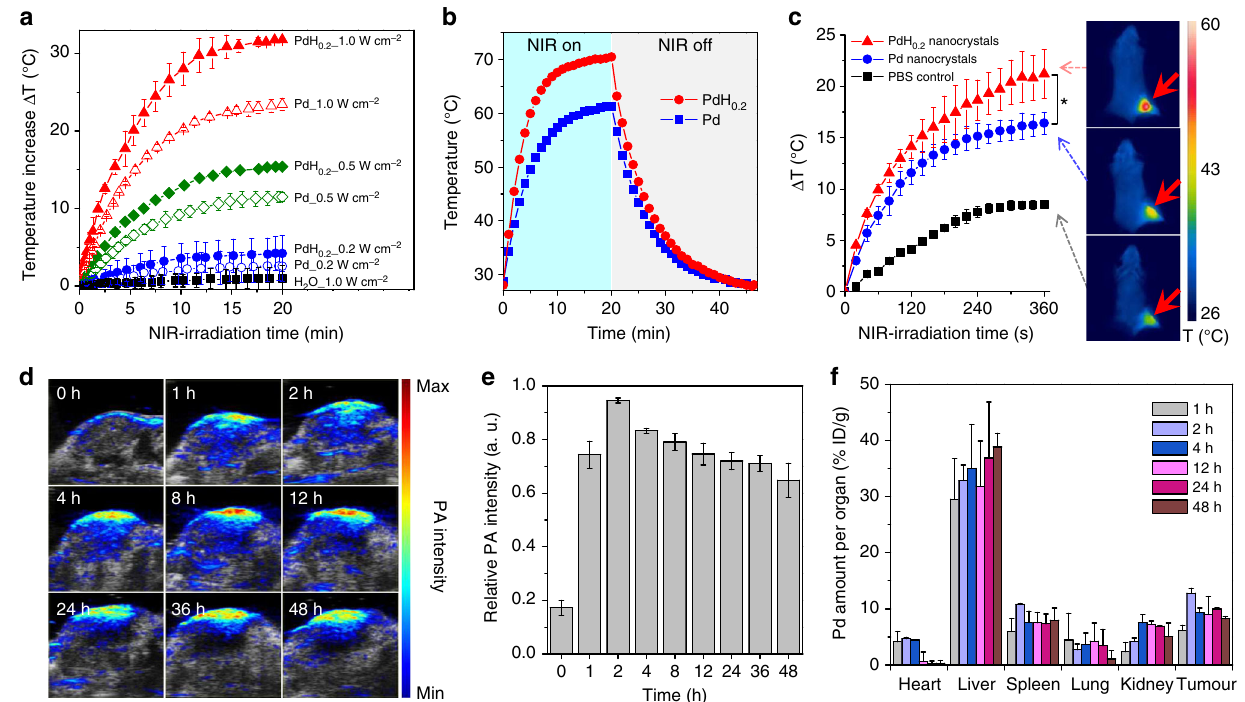
Fig. 4 NIR-photothermal and photoacoustic effects of PdH 0.2 nanocrystals. a Photothermal effect of PdH 0.2 and Pd nanocrystals in water ( n = 3). b Photothermal ef fi ciency evaluation of Pd and PdH 0.2 solutions (60 μ g mL − 1 ) under irradiation of 808 nm laser at the power density of 1 W cm − 2 which was turned off after irradiation for 20 min. c Photothermal imaging of tumour on 4T1 tumour-bearing mice ( n = 3). d PAI images of 4T1 tumour treated with PdH 0.2 nanocrystals ( n = 3). e , f Quantitative analysis of intratumoural accumulation and retention of PdH 0.2 nanocrystals from PAI ( e ) and ICP data ( f ). The aqueous solutions of PdH 0.2 and Pd nanocrystals (40 μ g mL − 1 ) were irradiated by the 808 nm laser with different power densities (0.2, 0.5 and 1.0 W cm − 2 ), and water without nanocrystals was used as the control to be irradiated by the 808 nm laser with the highest power density of 1.0 W cm − 2 . ICP data in ( f ) were collected at the different time points (1, 2, 4, 12, 24 and 48 h) post injection ( n = 3). Mean value and error bar are de fi ned as mean and